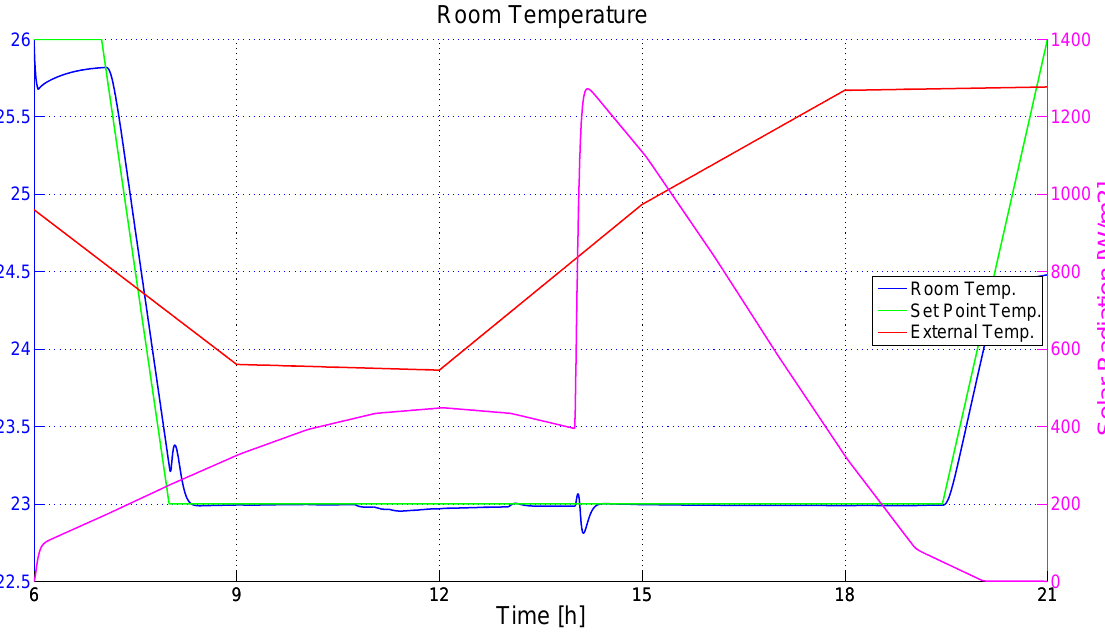
Figure 38. Control results (third scenario, modified control system, Comfort policy): MVs (heat pump, dimmer, and rolling shutters) and DV (presence of solar radiation).